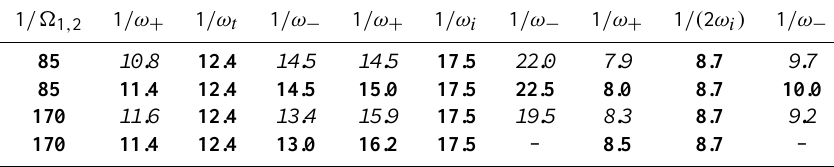
Fig. 5. (a) Normalized averaged spectrum of the isotherm (10 ◦ C) vertical displacements versus log ω from the A and B moorings in Septem- ber 2004. Numbers over the peaks are their periods. (b) Increased fragment of the spectrum surrounding the inertial and semidiurnal frequen- cies. The bold numbers 17 . 5 , 12 . 4 and 8 . 7 are the carrier periods. Table 2. Periods of the peaks of the isotherm displacement spectrum (bold) and the calculated periods in hours (italic). 1 /(cid:127) 1 ,